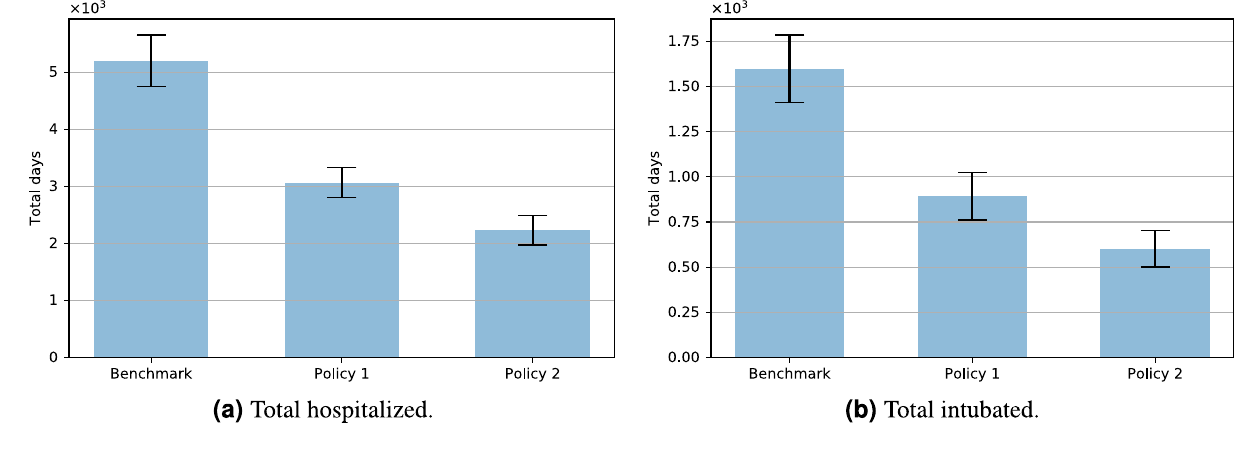
Figure 3. Policy comparison: aggregate outcomes.